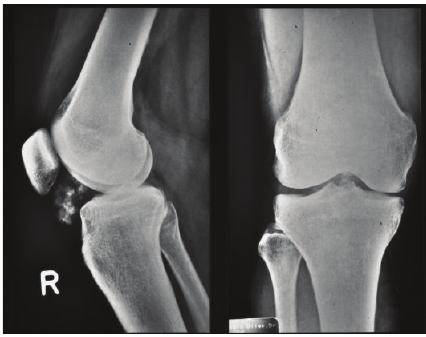
Figure 7: Plain radiography, anteroposterior and mediolateral view of the knee joint.